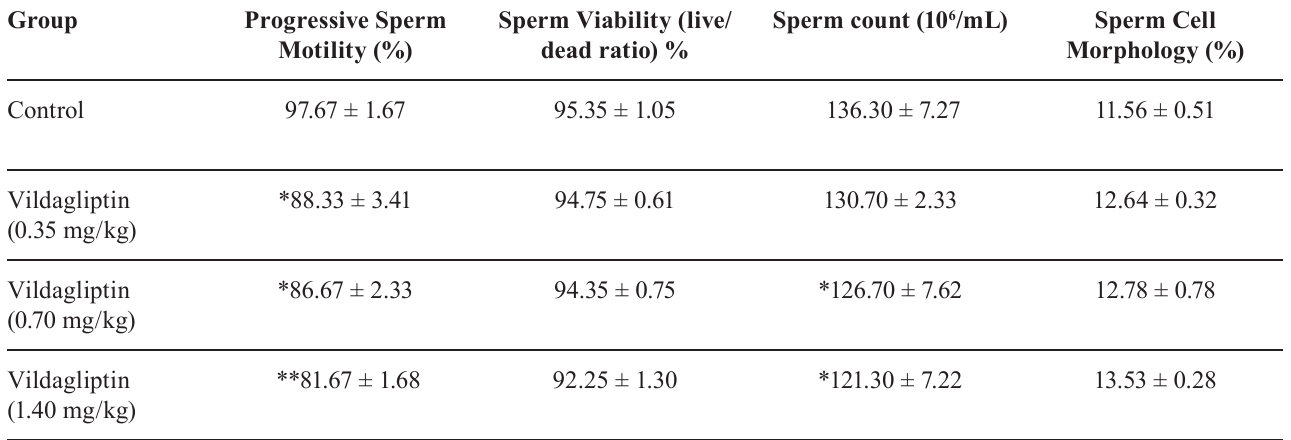
TABLE II – Effect of vildagliptin on sperm parameters of Wistar rats (Recovery)